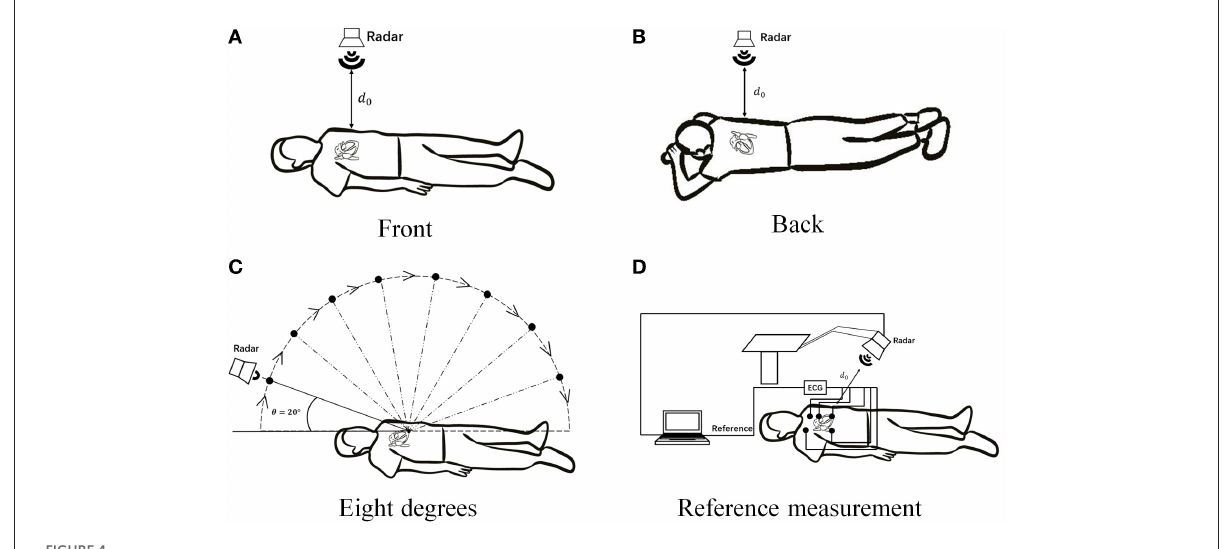
FIGURE4 Schematic diagram of multiscale detection of a cardiac signal. (A) Front orientation measurement, (B) back orientation measurement, (C) along-the-arc measurements, and (D) reference measurement.